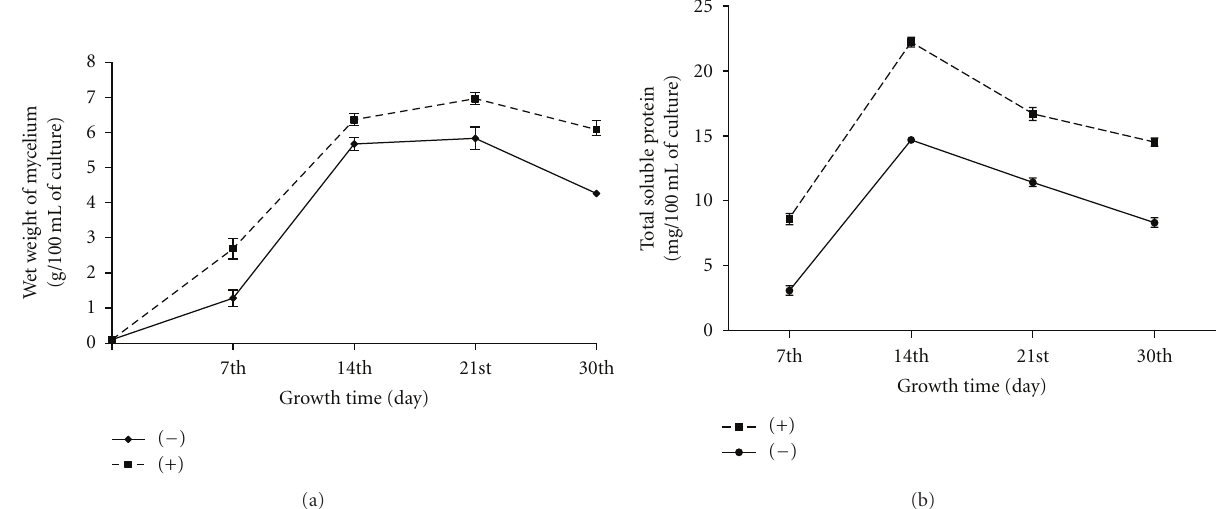
Figure 2: (a) Growth kinetics of T. indica isolate grown in presence (+) and absence ( − ) of host factor(s) in terms of total biomass production (g/100mL on wet basis) in di ff erent time intervals. (b) Total soluble protein content of T. indica isolate grown in presence (+) and absence ( − ) of host factor(s) (mg/100 mL of culture) at di ff erent time